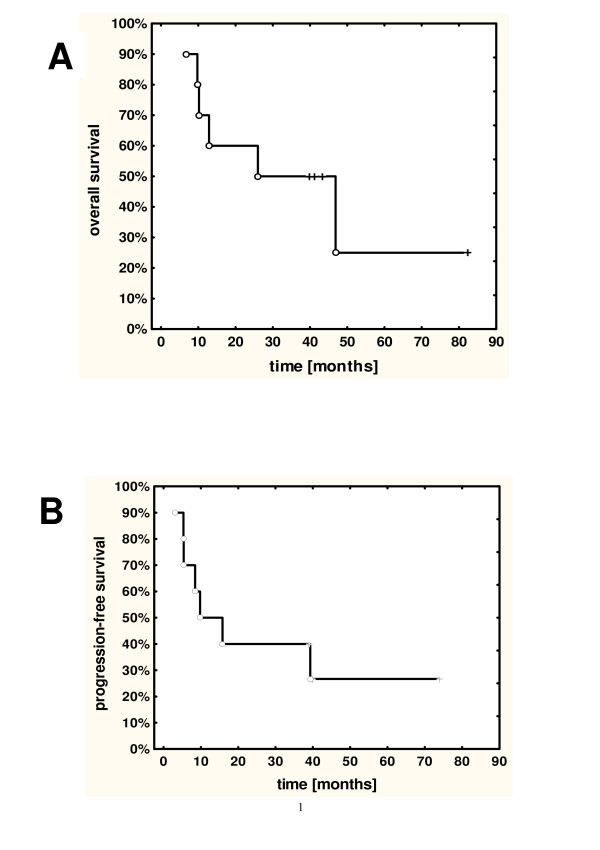
Overall survival (A) and progression-free survival (B) of n = 10 consecutive patients with glioblastoma multiforme with oligodendroglial component (GBMO).